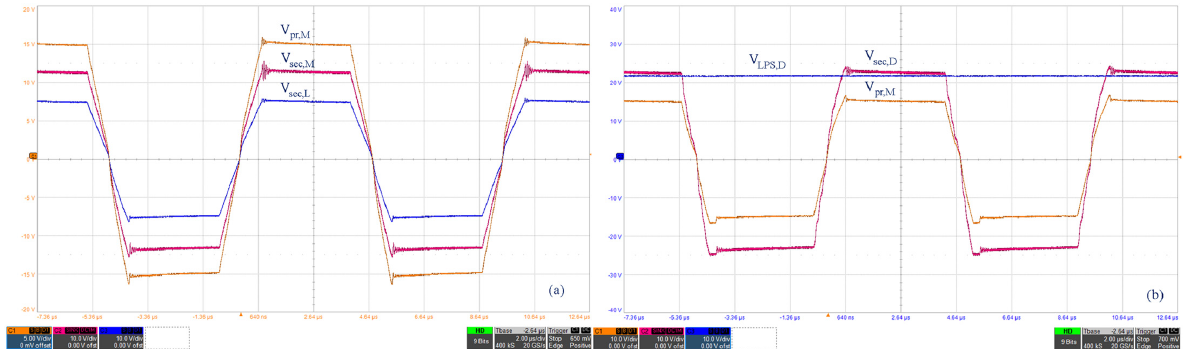
Figure 23. ( a ) Primary and secondary-side voltage of the Main HF transformer with a secondary voltage of a load transformer. V pr,M = 5 V/div V sec,M = 10 V/div, V sec,L = 10 V/div ( b ) Primary-side voltage of the Main HF with the positive secondary voltage of load transformer devoted to the SiC MOSFET devices and the regulated DC voltage V LPS,D . V pr,M = 10 V/div V sec,L = 10 V/div, V LPS,D = 10 V/div, t = 2 μ s.